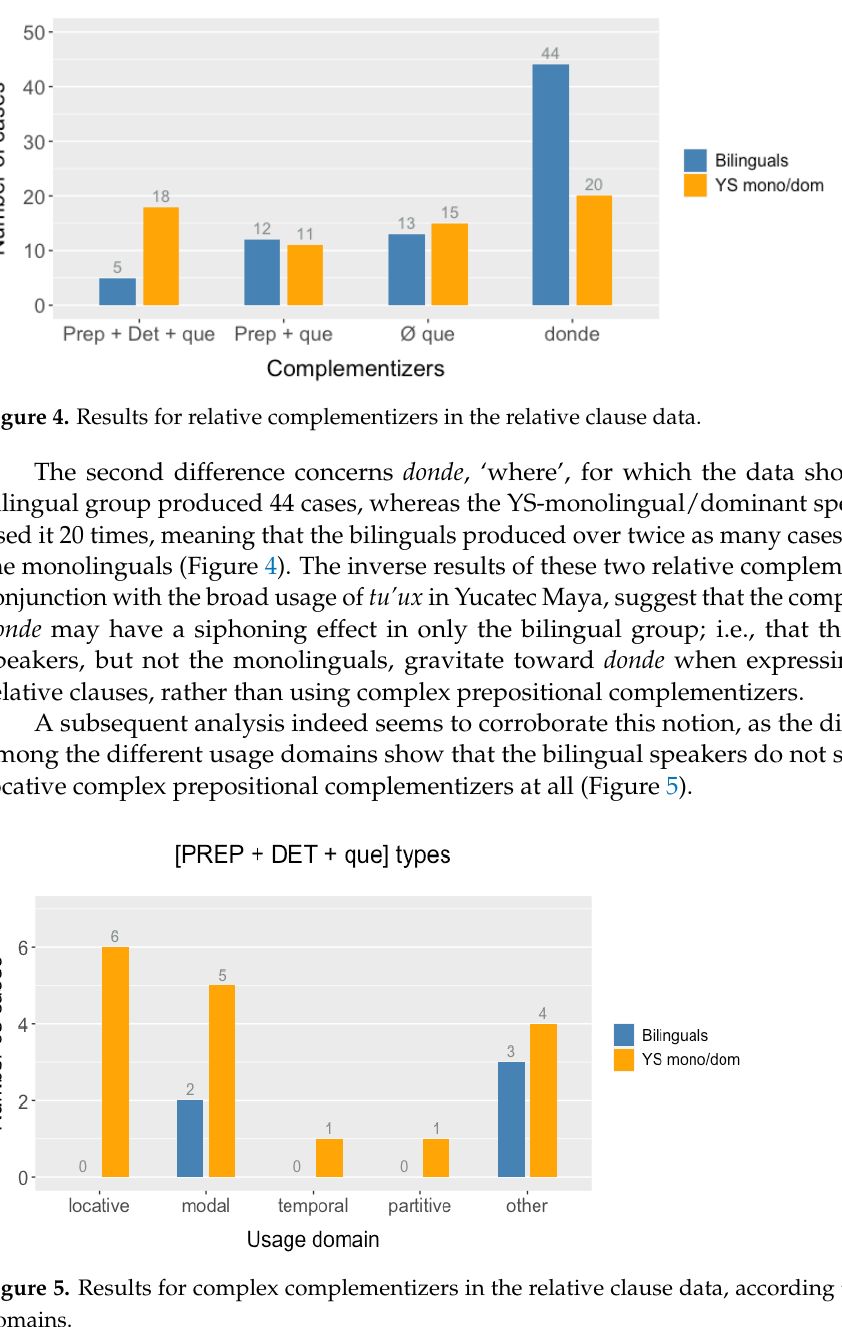
Figure 6. Results for bare que in the relative clause data, according to the usage domains. In more concrete terms, the numbers displayed in Figure 6 reveal two interesting results. First, the bilingual group does not produce any single instance of locative bare que , as opposed to the monolingual group, with a total of eight occurrences. Second, in all other usage domains, the groups produce similar numbers, highlighting the particularity of the locative relative complementizers in the bilingual speakers. All in all, the usage domains of bare que seem to support the notion of a gravitational effect of donde in the bilingual group, suggesting, again, the possible influence of tu’ux from Yucatec Maya. Turning now to the usage domains of determiner-less prepositional complementizers (PREP + que ), it is, first of all, noteworthy that all occurrences of these constructions included the prototypically locative preposition en , ‘in’, although it appears in different